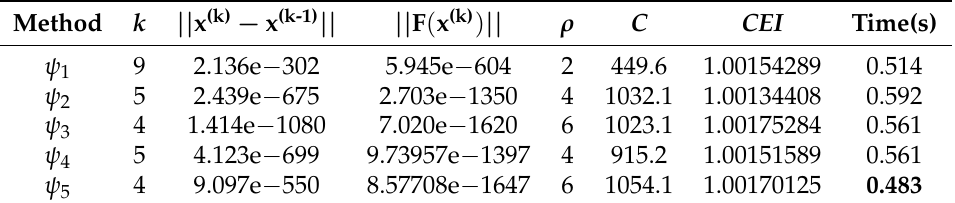
Table 4. Performance of methods for Example 2.